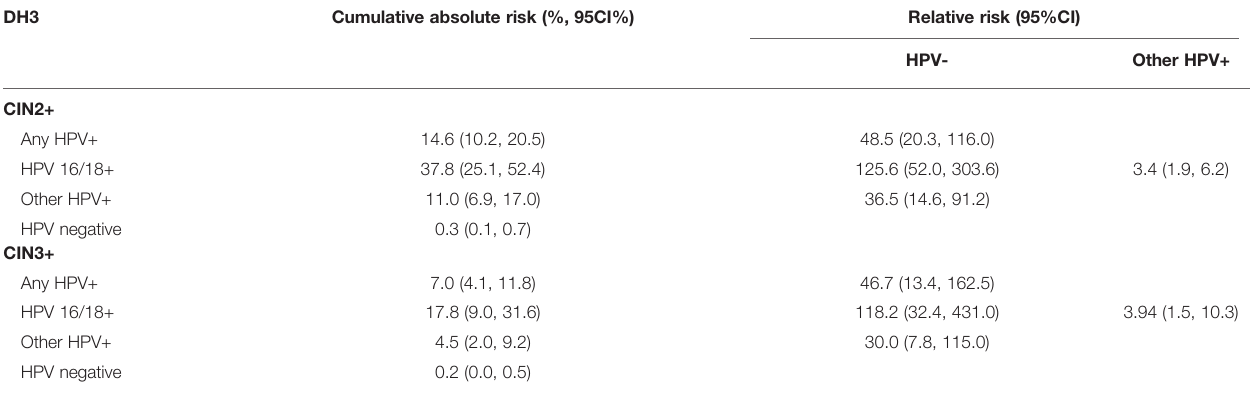
TABLE 3 | The performance for risk prediction in cervical cancer screening. Cumulative absolute risk (%,